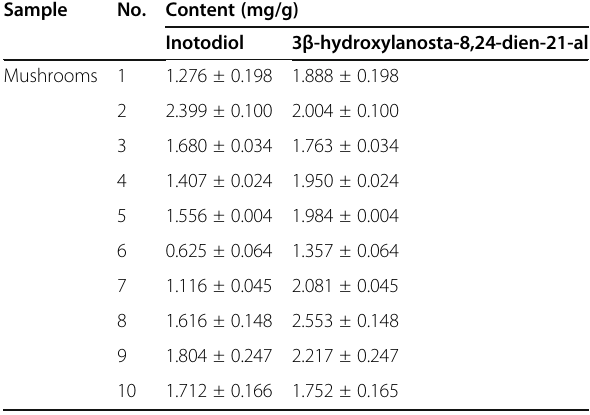
Table 1 Quantitative analysis of two marker compounds in I. obliquus mushrooms and its commercial products ( n = 3) Sample